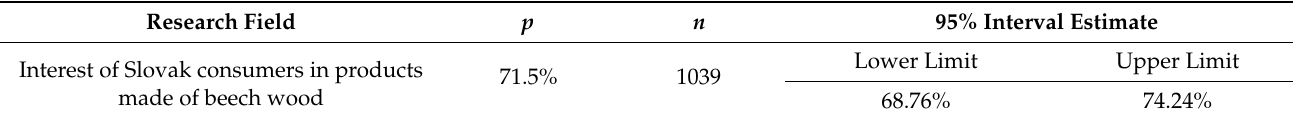
Table 4. Interval estimate for Hypothesis